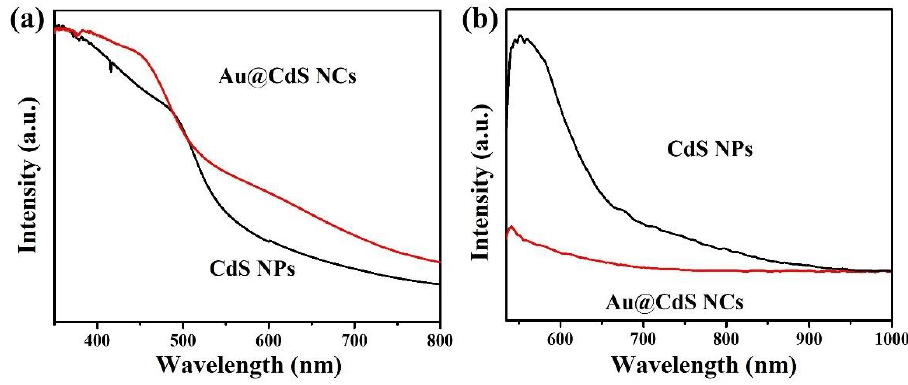
Figure 6. The ( a ) UV-vis absorption and ( b ) PL spectra of CdS NPs and Au@CdS nanocomposites. The photocatalytic performance of as-prepared Au@CdS nanocomposites was eval- uated by monitoring the hydrogen evolution rate (HER) from 50 mL de-ionized water with 0.1 M sodium sulfide as a scavenger at pH = 12 under blue-LED light excitation (5 W, λ max = 420 nm). Figure 7 a shows the average HER of Au@CdS nanocomposites synthesized at the different concentrations of CdS precursors under a reaction temperature of 120 °C for 2 h. The average HER of Au@CdS nanocomposites are 0.262 (1 mM CdS precursors), 0.415 (2.5 mM CdS precursors), 0.676 (5 mM CdS precursors), and 0.131 mmolh −1 g −1 (10 mM CdS precursors), respectively. This variation in the HER of Au@CdS nanocomposites is consistent with the observation of average crystalline sizes. The maximum average crys- talline sizes and HER have been obtained at CdS precursors of 5 mM. This result is at- the high concentration of CdS precursor, resulting in more CdS NPs in the photocatalyst per unit mass, which makes the photocorrosion phenomenon more obvious, thereby re- ducing the photocatalytic hydrogen production.